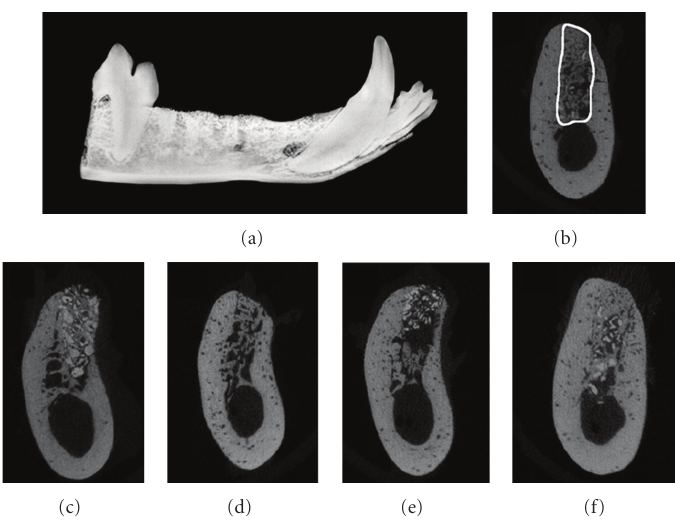
Figure 2: Representative image of a conventional mandibular radiograph (a) and µ CT slices (b–f) within the middle of the distal root, 4th premolar extraction sockets after the six-week healing time. (b) µ CT image of an extraction socket showing the region of interest analyzed for BV/TV and BMD. (c) Bovine xenograft particulate and collagen plug (X), (d) bone putty only (Bp), (e) xenograft particles sandwiched between layers of bone putty placed in the coronal and apical aspect, (Bp-X-Bp), and (f) a 3 :1 mixture by weight of bone putty and xenograft particles, respectively (3Bp-X). Residual xenograft particles (appearing denser than the surround bone) can be seen in within the extraction sockets in panels (c), (e), and (f). Table 2: A comparison of bone volume to total volume ratios (BV/TV) and bone mineral density (BMD) values across all treatment arms. Treatment